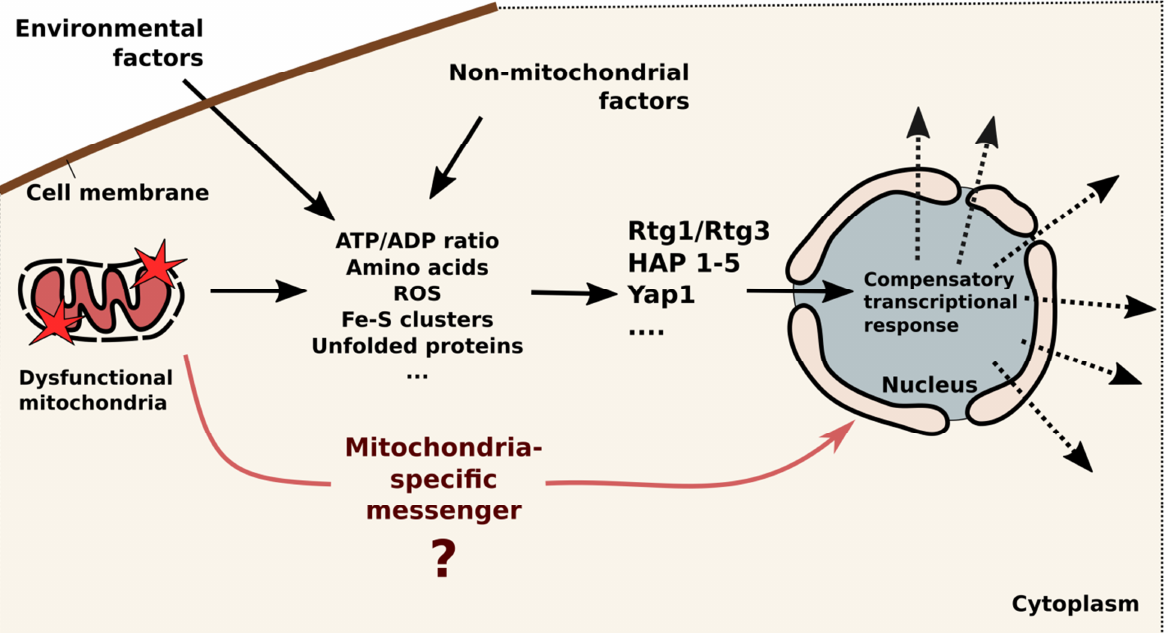
FIGURE 1: Schematic illustration of mitochondria-to-nucleus signaling in yeast. Mitochondrial dysfunction initiate change in concentra- tions of several factors in the cytoplasm (ATP, amino acids, ROS, Fe-S clusters, unfolded proteins and others), these concentrations also depend on environmental and non-mitochondrial factors. Then factors are detected by the cytosolic sensors (RTG1/RTG3, Hap 1-5, Yap1 and others) which transmit the signals to the nucleus leading to compensatory transcriptional response. Question mark indicates that the direct signaling routes are still not